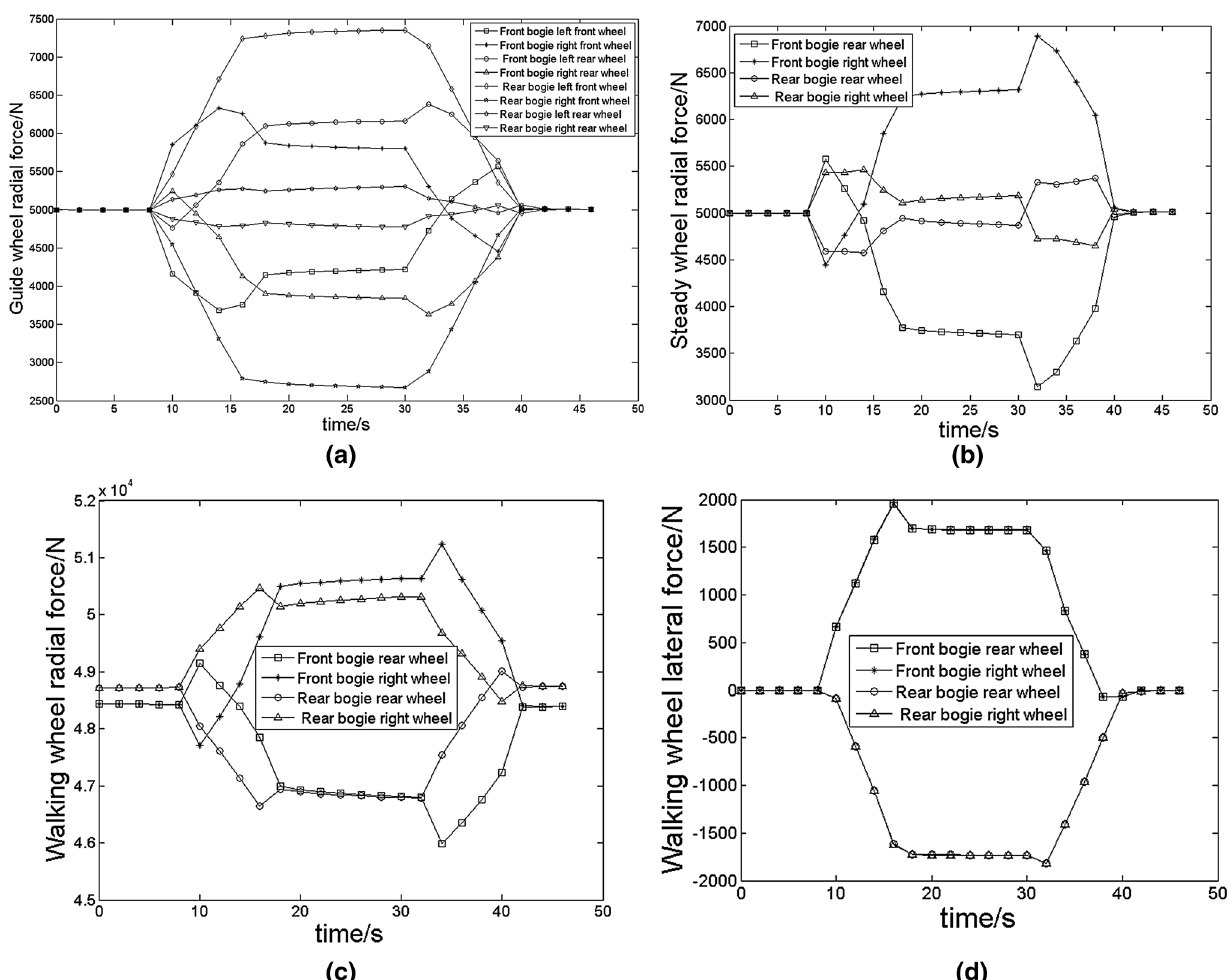
Fig. 10 Load variation regularity of each wheel in the bogie, a guide wheel radial force, b steady wheel radial force, c walking wheel radial force, d walking wheel cornering